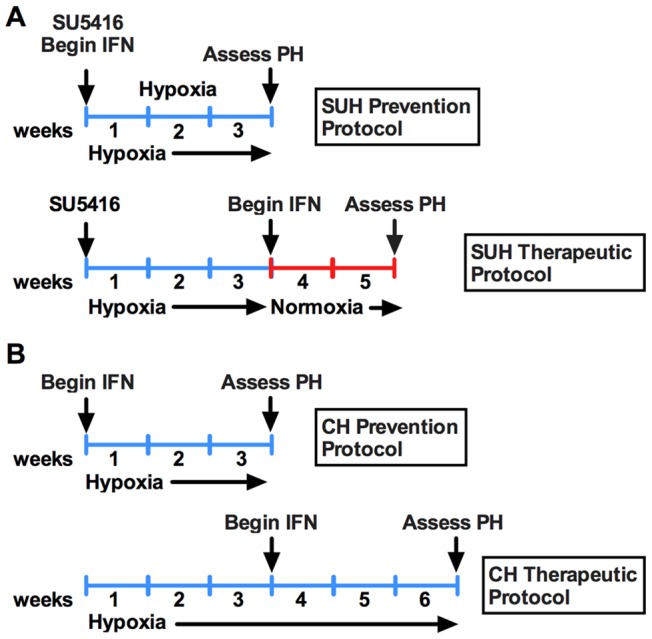
Schema of IFNα treatment protocols.(A) Schema of prevention and therapeutic protocols for IFNα treatment in SU5416/hypoxia-induced PH in rats. (B) Schema of prevention and therapeutic protocols for IFNα treatment in hypoxia-induced PH in mice.